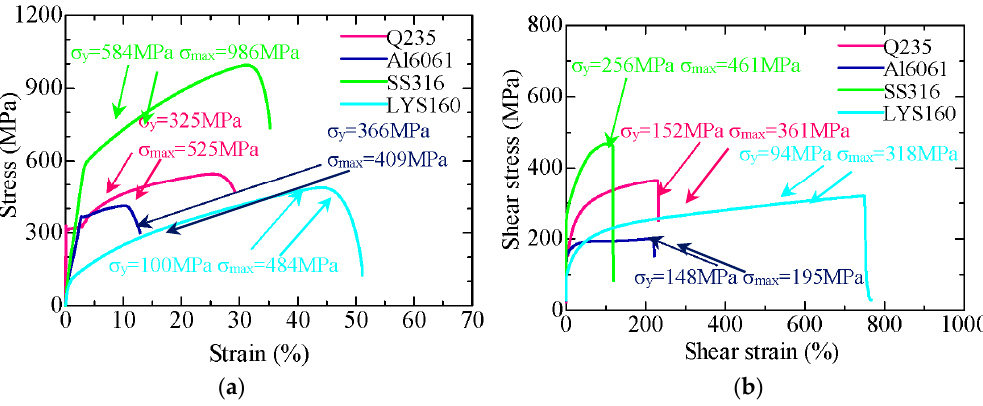
Figure 8. Stress–strain curves under monotonic test. ( a ) Tension test results; ( b ) Torsion test results.